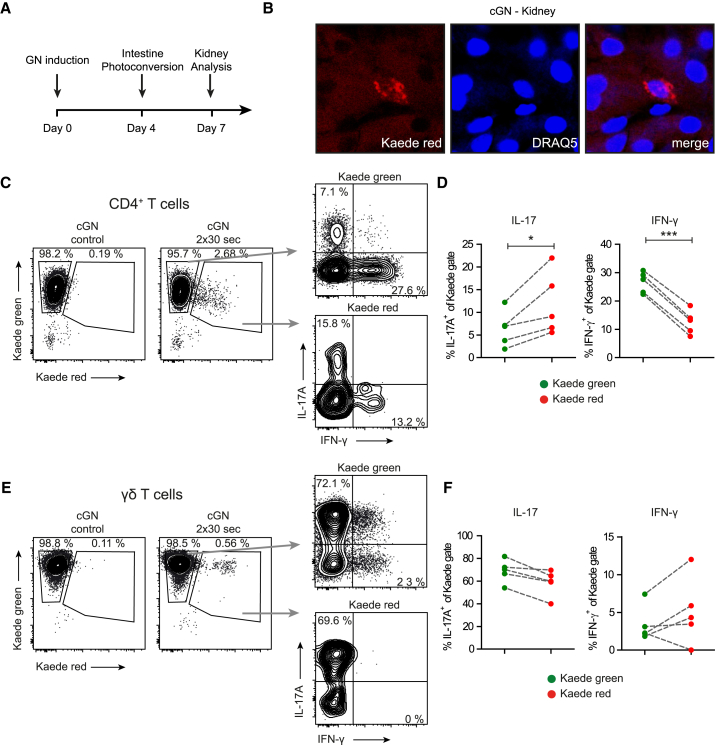
Th17 Cells in Glomerulonephritis Migrate from the Intestine into the Kidney(A) Experimental procedure: 4 days after cGN induction, photoconversion of the small intestine was performed, and at day 7, the kidneys were analyzed.(B) Confocal microscopy of Kaede red+ cells in a renal tissue section of Kaede-tg mice (nucleus: DRAQ5-staining, blue).(C) Flow cytometry of renal CD4+ T cells from Kaede-tg mice after cGN induction and photoconversion of the small intestine and controls. Kaede green+ cells and Kaede red+ cells were assessed for IL-17A and IFN-γ expression.(D) Quantification of IL-17A and IFN-γ expression in the respective Kaede population.(E and F) Analysis and quantification of IL-17A and IFN-γ expression in Kaede green+ and Kaede red+ γδ T cells. Data are representative of three independent experiments. Symbols represent individual data points, with the mean as a horizontal line.∗p < 0.05, ∗∗∗p < 0.001. See also Figure S3.